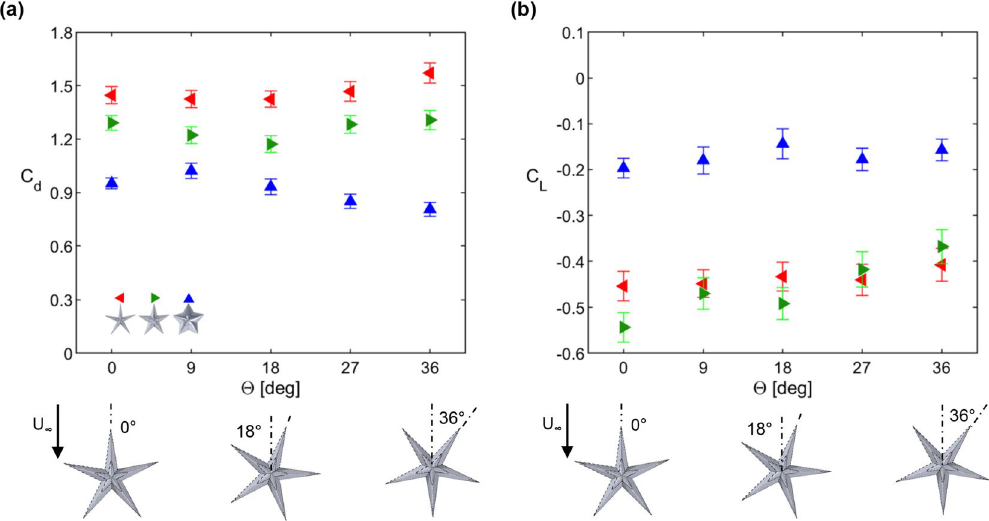
Figure 2. Drag and lift coefficient values for sea star models for varying orientation angles at flow speed U ≈ 0.46 ms − 1 . Given the pentaradial symmetry of the sea star models, C d and C L for (cid:31) = 36 ◦ to (cid:31) = 72 ◦ can be estimated by mirroring the data shown in this